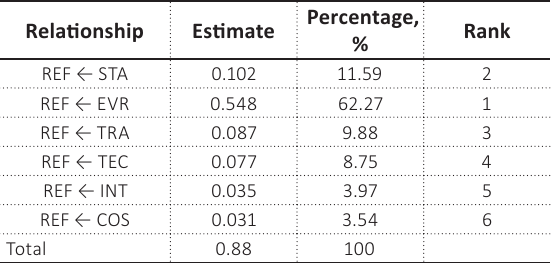
Table 6. Factors affecting the accrual accounting reform in Vietnam’s public sector